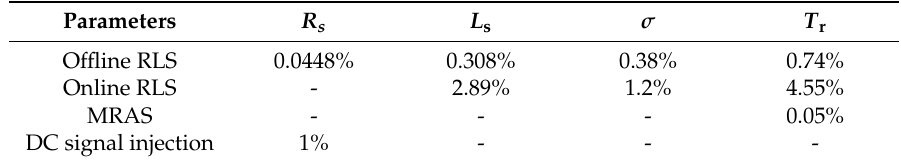
Table 5. Estimated error of the selected identification algorithms at steady